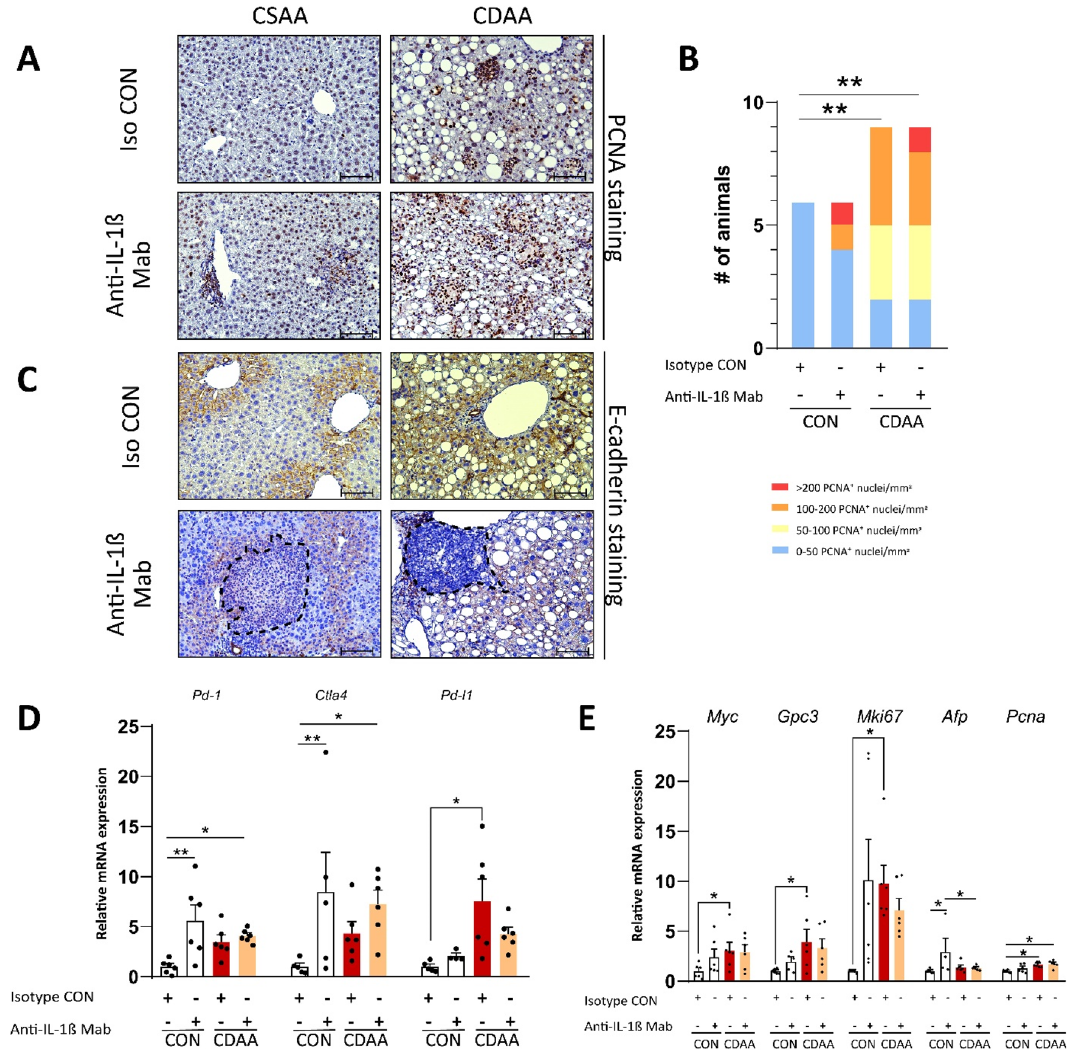
Figure 5. Hepatic microenvironment. Immunohistochemical evaluation of proliferation by assessing PCNA + nuclei ( A , B ) and invasiveness by assessing E-cadherin staining ( C ) (n = 6–9/group). qRT-PCR analysis of key immune checkpoints ( D ) and proto-oncogenes ( E ) (n = 4–6/group). CDAA, Choline Deficient L-Amino Acid-defined diet; CON, control diet; Iso CON, isotype control; Anti-IL-1β, anti-interleukin-1β monoclonal antibody; PCNA, proliferating cell nuclear antigen. Scale bar shows 100 µm. Two-way ANOVA, Fisher’s LSD post hoc test, Fisher’s exact test, * P < 0.05, ** P < 0.01, *** P <